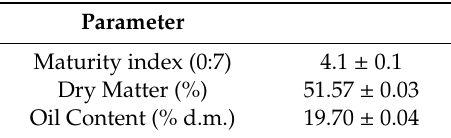
Table 1. Olive fruit characterization. Data are expressed as mean ± confidence interval ( n = 3) at p = 0.05.